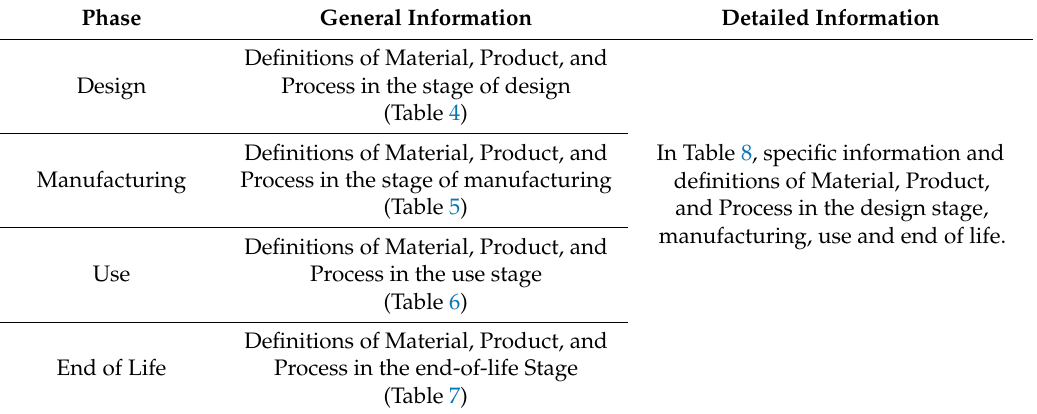
Table 3. General and specific information on sustainable machining indicators.